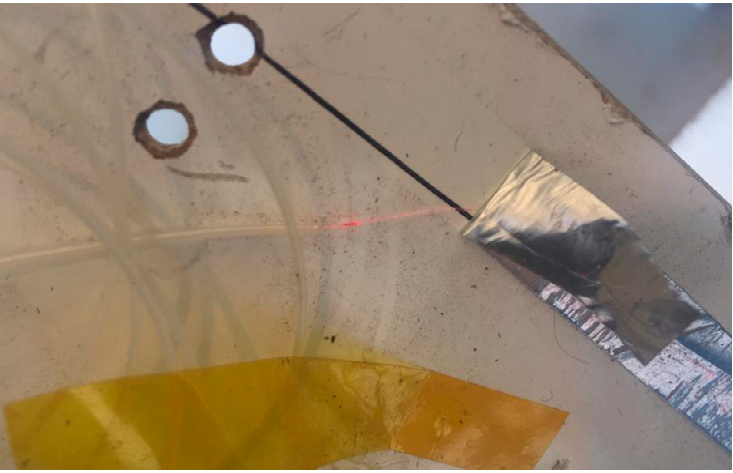
Figure 21. Light escaping the fibre at a microcrack; visibility produced by the VLF.